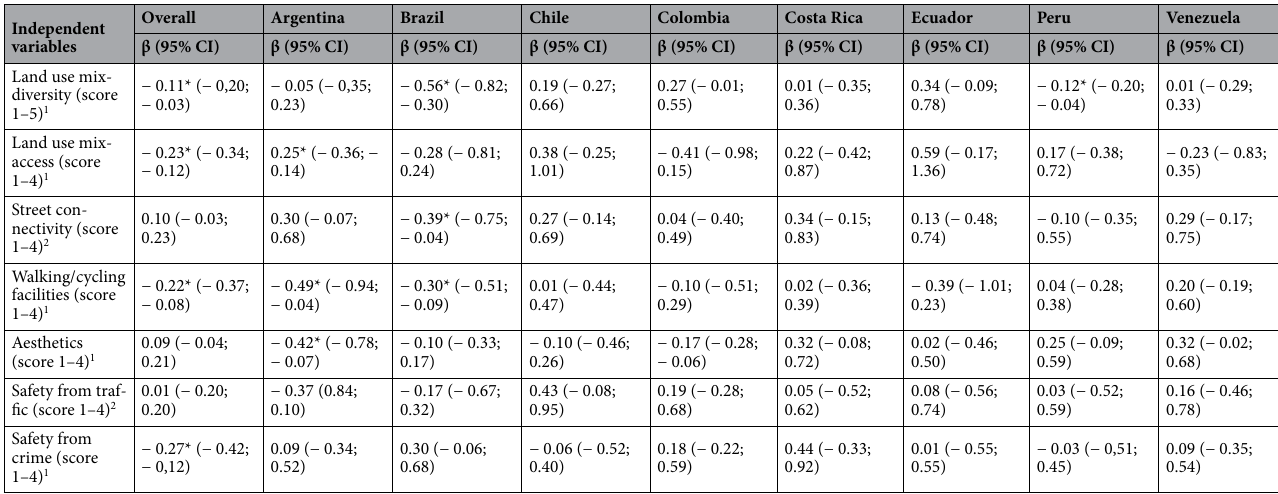
Table 4. Linear regression models (unstandardized β, 95% CI) for perceived urban environment attributes and neck circumference (cm). Linear regression models adjusted for age, sex, marital status, work status, socioeconomic level, and energy intake. *Indicates statistically significant associations (p < 0.05). CI confidence interval. 1 Higher scores indicate perception of higher land use mix-diversity, higher land use mix-access, more walking/cycling facilities, better aesthetics, and more safety from crime. 2 4-point scale: strongly disagree (1), disagree (2), agree (3), strongly agree (4).